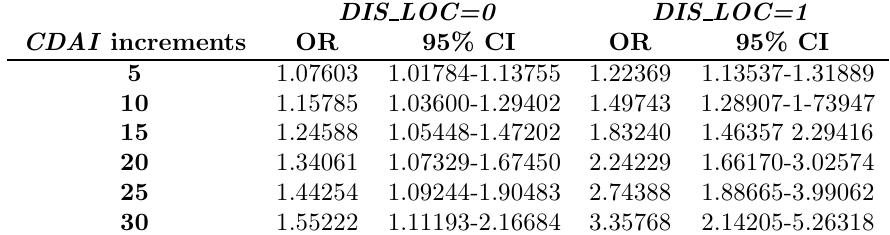
Estimated odds ratio (with 95% confidence limits) for several increments in the predictor CDAI for disease locations Ileum and Colon or Ileocolon DIS LOC=0 DIS LOC=1 CDAI increments OR 95% CI